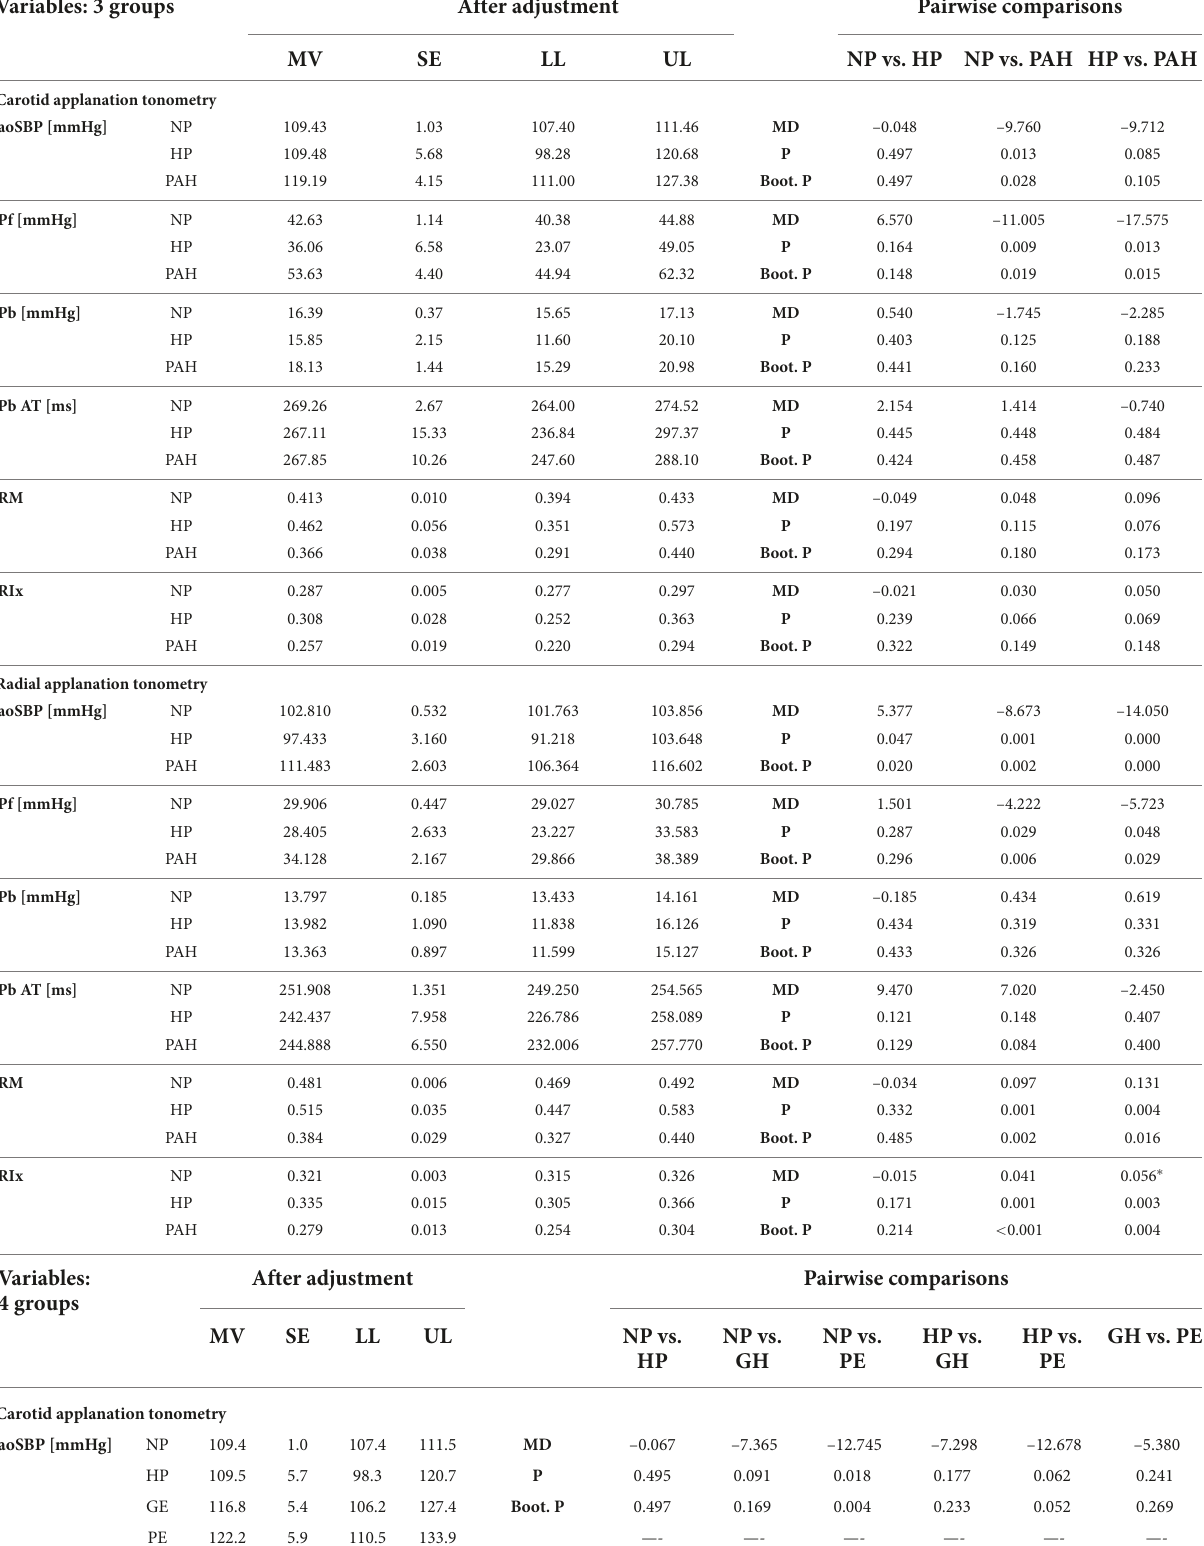
TABLE 3 Carotid and radial applanation tonometry-derived central blood pressure levels and waveform related parameters: comparison after adjustments (ANCOVA: 3 and 4 groups). Variables: 3